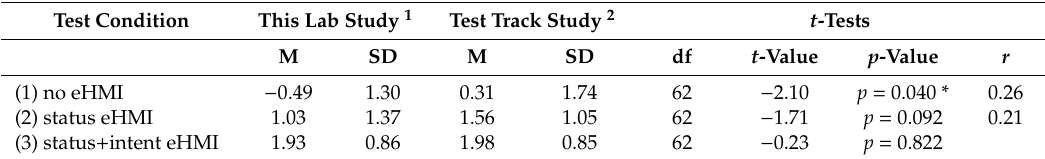
Table 2. Two-sample t